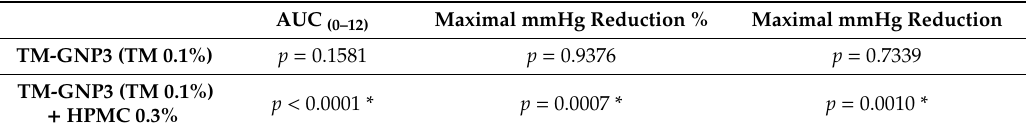
Table 5. p -values obtained after one-way ANOVA comparison between the reference marketed formulation and TM-GNP3 with and without viscous HPMC. (* significant di ff erences p < 0.001).